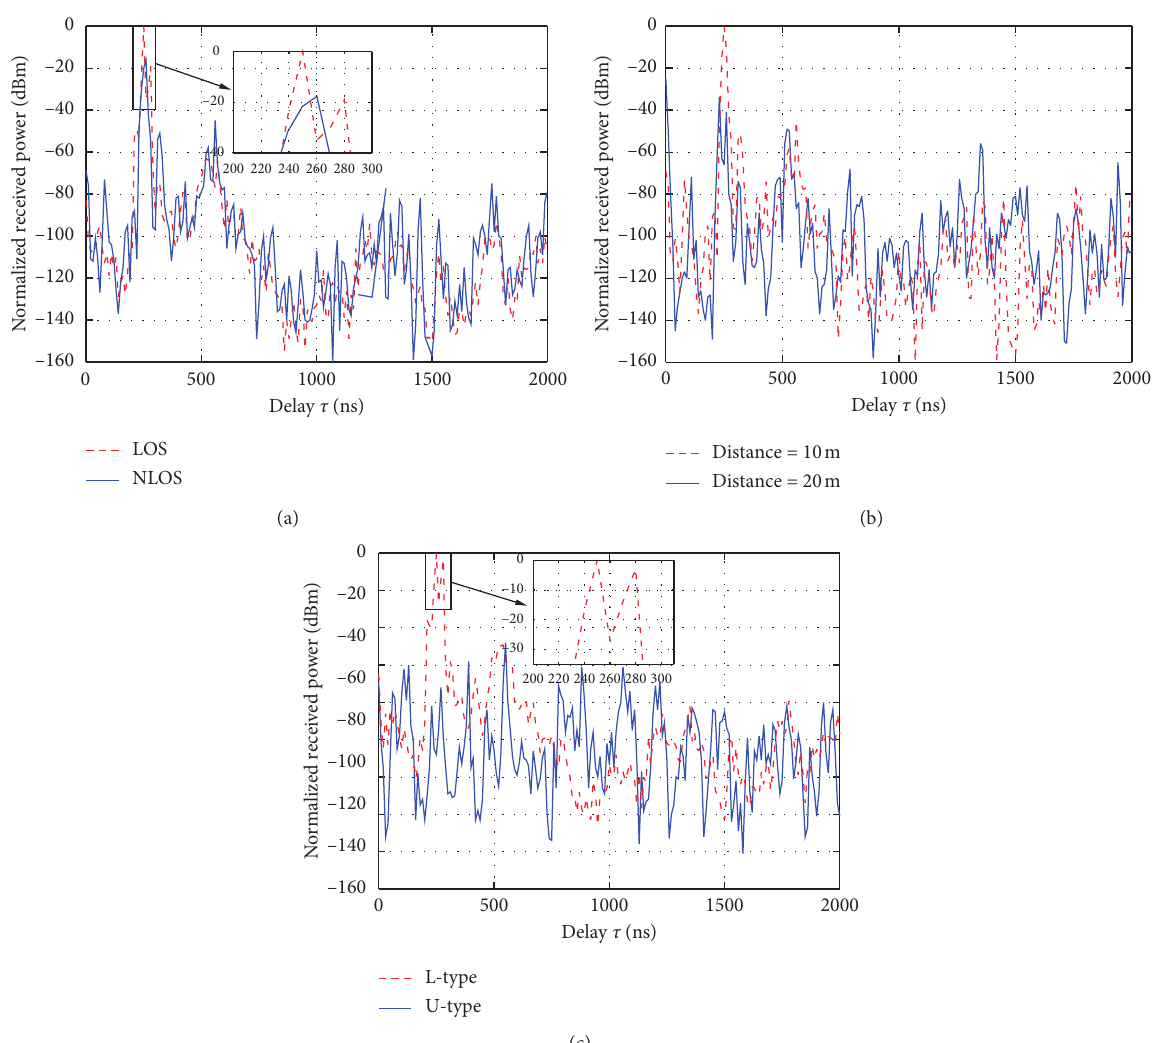
Figure 6: Comparison of PDPs under NLOS conditions: (a) comparison of multipath conditions under LOS and NLOS conditions with a fixed transmission power of 10dBm and distance of 10m; (b) comparison of multipath conditions with different distances; (c) comparison of multipath conditions in “L” and “U” type